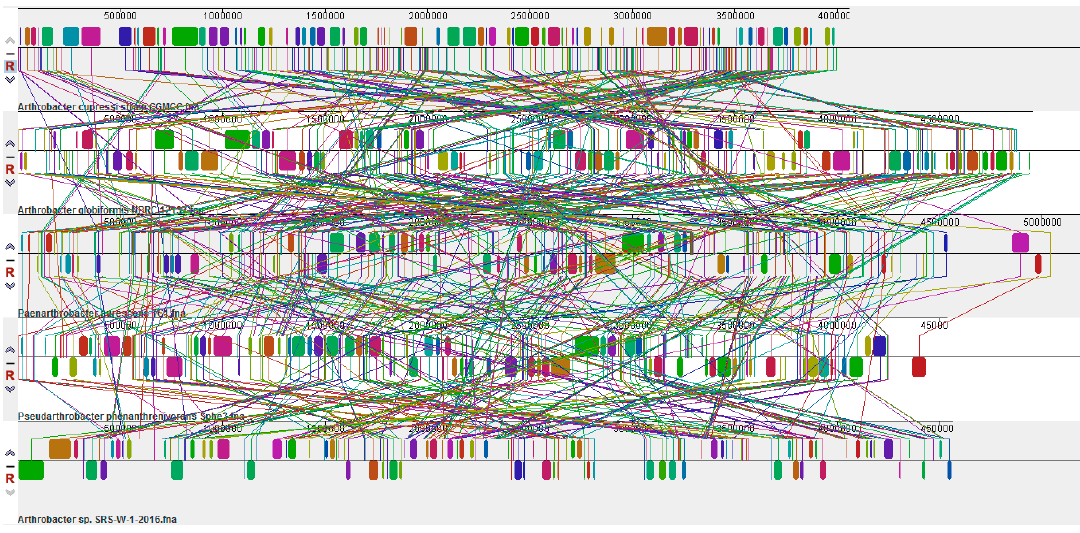
Figure 8. Whole genome comparative alignments between Arthrobacter sp. SRS-W-1-2016 with its closest functional relatives- Pseudoarthrobacter phenanthrenivorans strain Sphe3; Phenarthrobacter aurescens TC1; A . globiformis strain NBRC12137; and A . cupressi strain CGMCC. Each genome analyzed is presented horizontally with the scale showing the sequence coordinates and the conserved segments represented as the colored blocks which are connected across genomes. Blocks that are shifted downward in a genome represent those segments that are inverted relative to the reference genomes. The aligned region is in the forward orientation relative to the first genome sequence if a block lies above the center line; blocks below the center line indicate regions that align in the reverse complement (inverse) orientation of the reference genome. Genomic regions falling outside the blocks lack a detectable homology among the genomes analyzed.